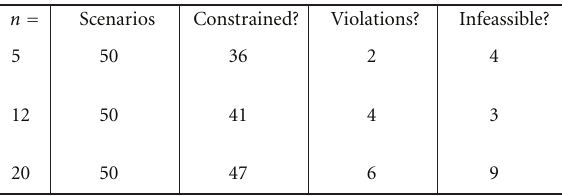
green lines indicate wireless links; and blue stars are goal configurations.